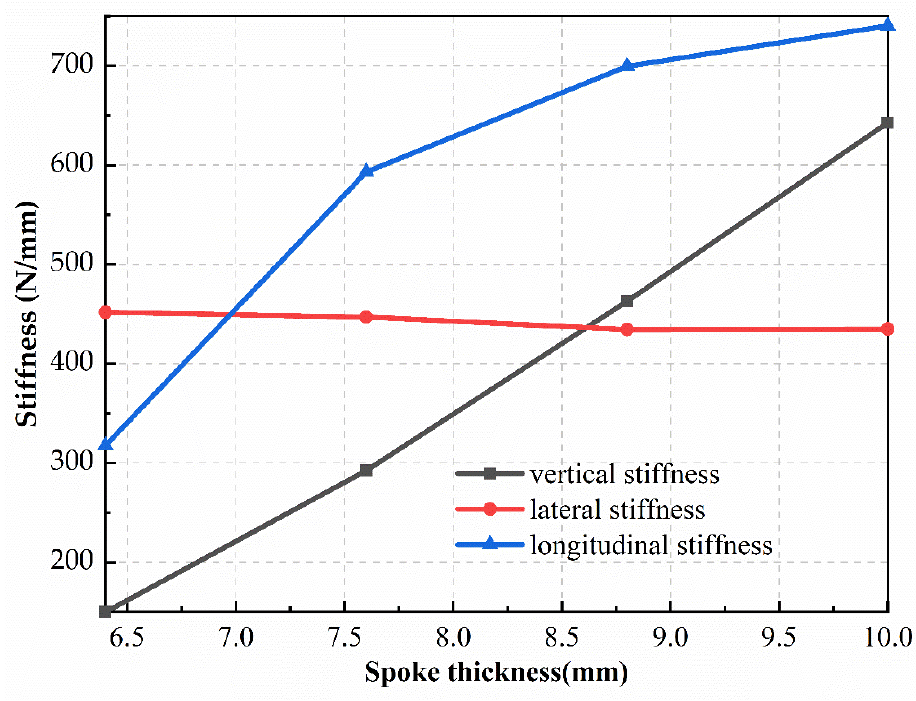
Figure 9. Effects of the spoke thickness on the three-dimensional stiffnesses of the FS-NPT.